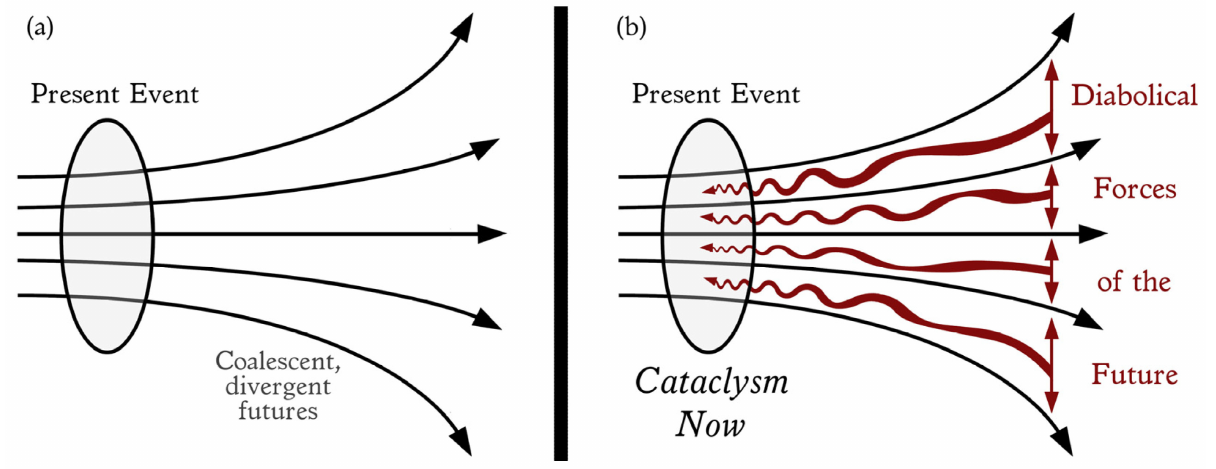
Figure 3. ( a ) Deleuze’s branching structure of time, with divergent futures coalescing but not assimilating, within the present event. ( b ) The tensions between these futures being intensified and injected into the present, causing a cataclysm